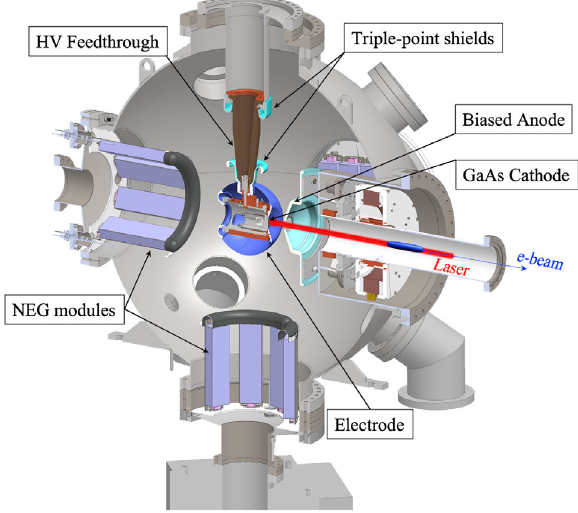
FIG. 1. Cross-sectional view of the BNL HVDC